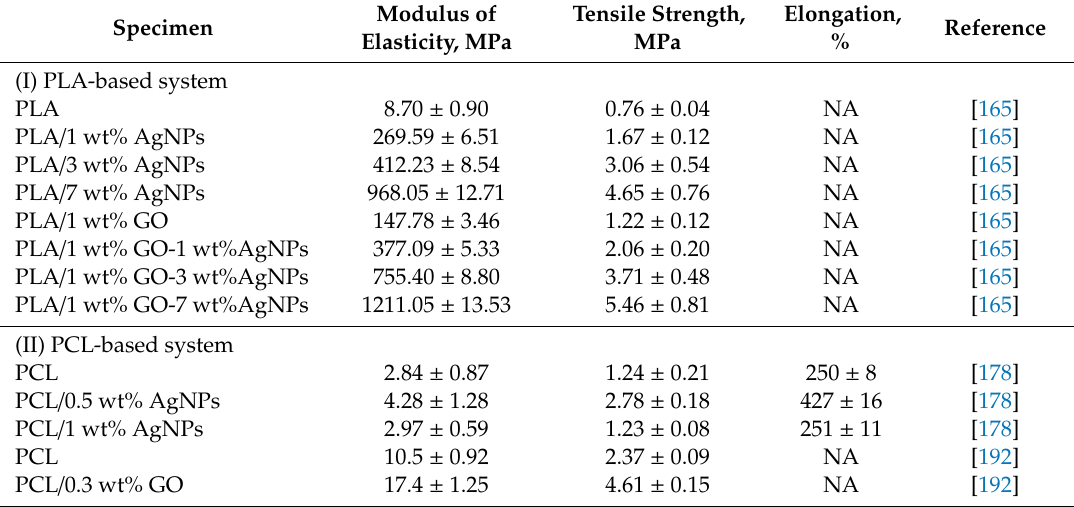
Table 2. Tensile properties of electrospun PLA- and PCL-based fibrous sca ff olds reinforced with AgNPs and / or GO nanofillers. Specimen